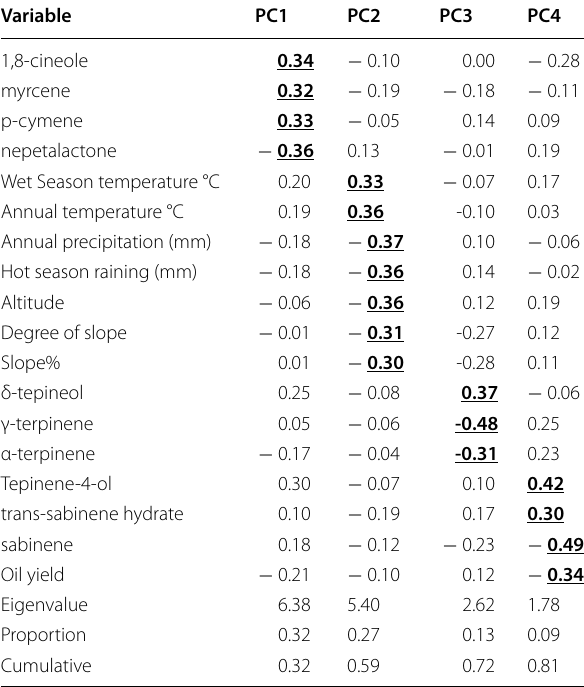
Table 5 Matrix of coefficients of Eigenvectors, eigenvalues and variance of the first four principal components extracted from main essential oil compositions and climatic factors in